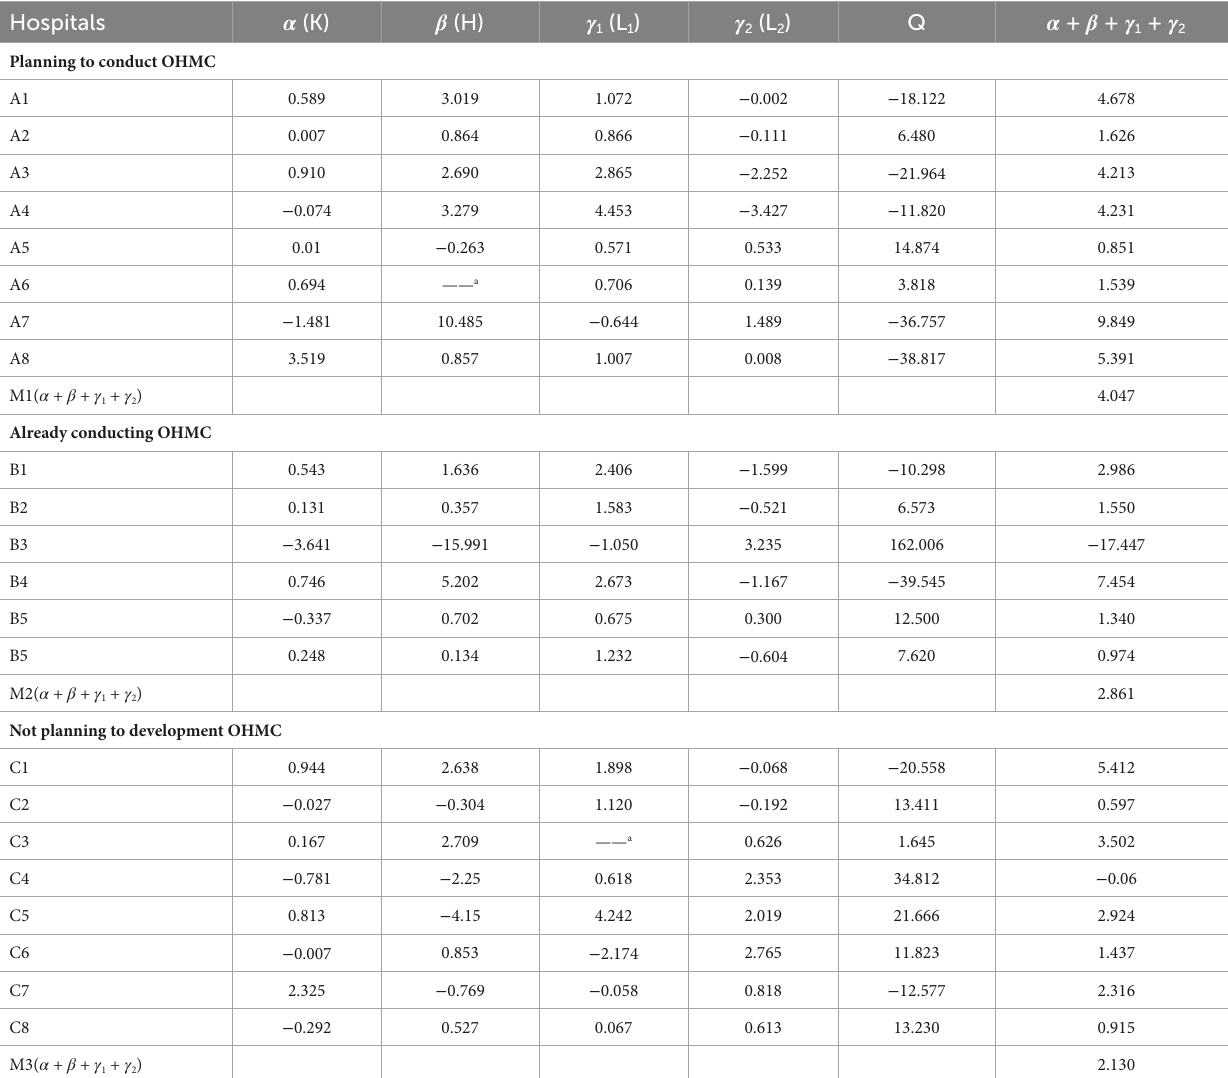
TABLE 3 22 Public hospitals’ model